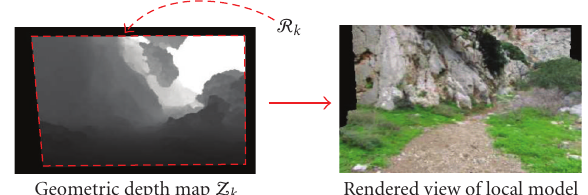
Figure 2: A geometric depth map Z k of a local model is shown on the left (this map is assumed to be defined only over region R k on the image plane). By combining this geometric map with a photometric map, a local 3D model can be created, which can be used for providing rendered views of the scene around the key- position of the local model. One such view is shown